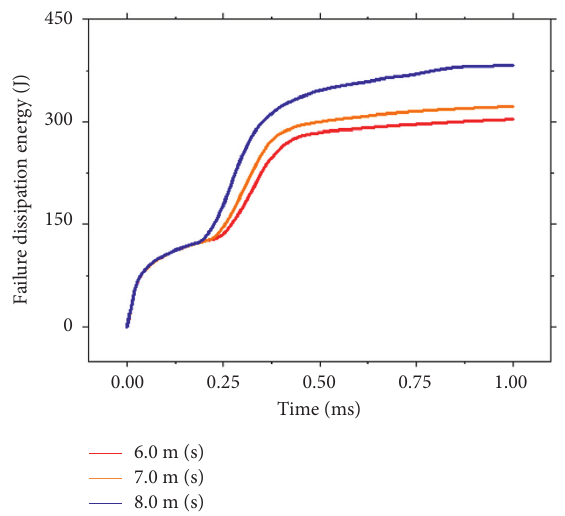
Figure 16: The failure energy consumption of Model